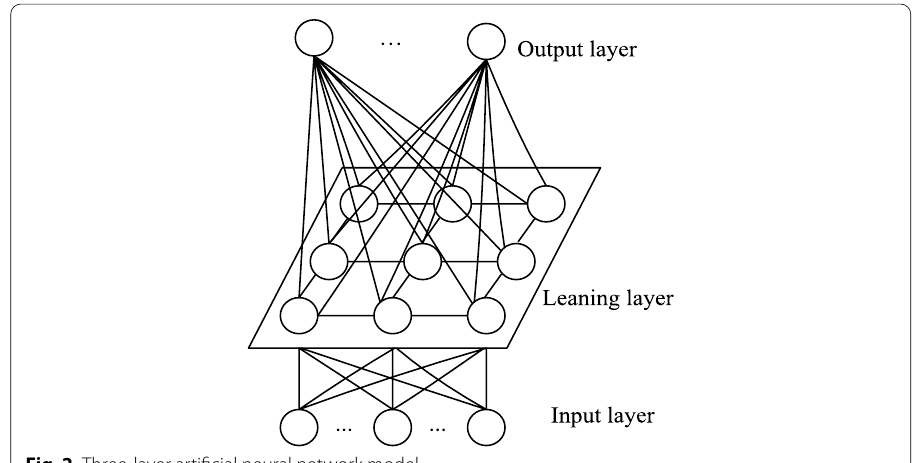
Fig. 2 Three-layer artificial neural network